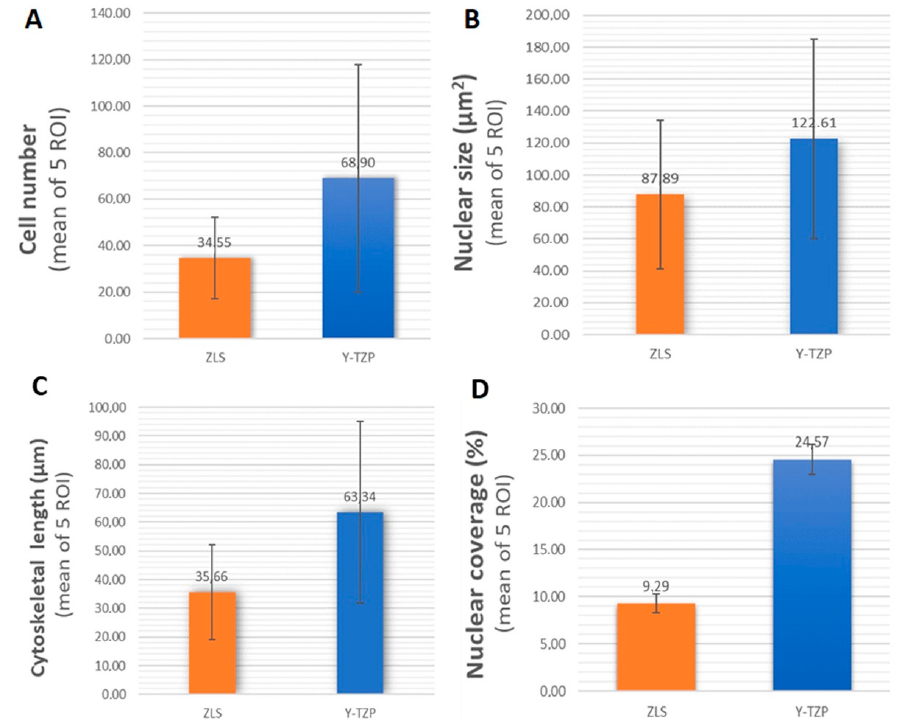
Figure 5. Graphic representations of number of cells ( A ), average size ( B ), length of the cytoskeleton ( C ), and occupied area ( D ).